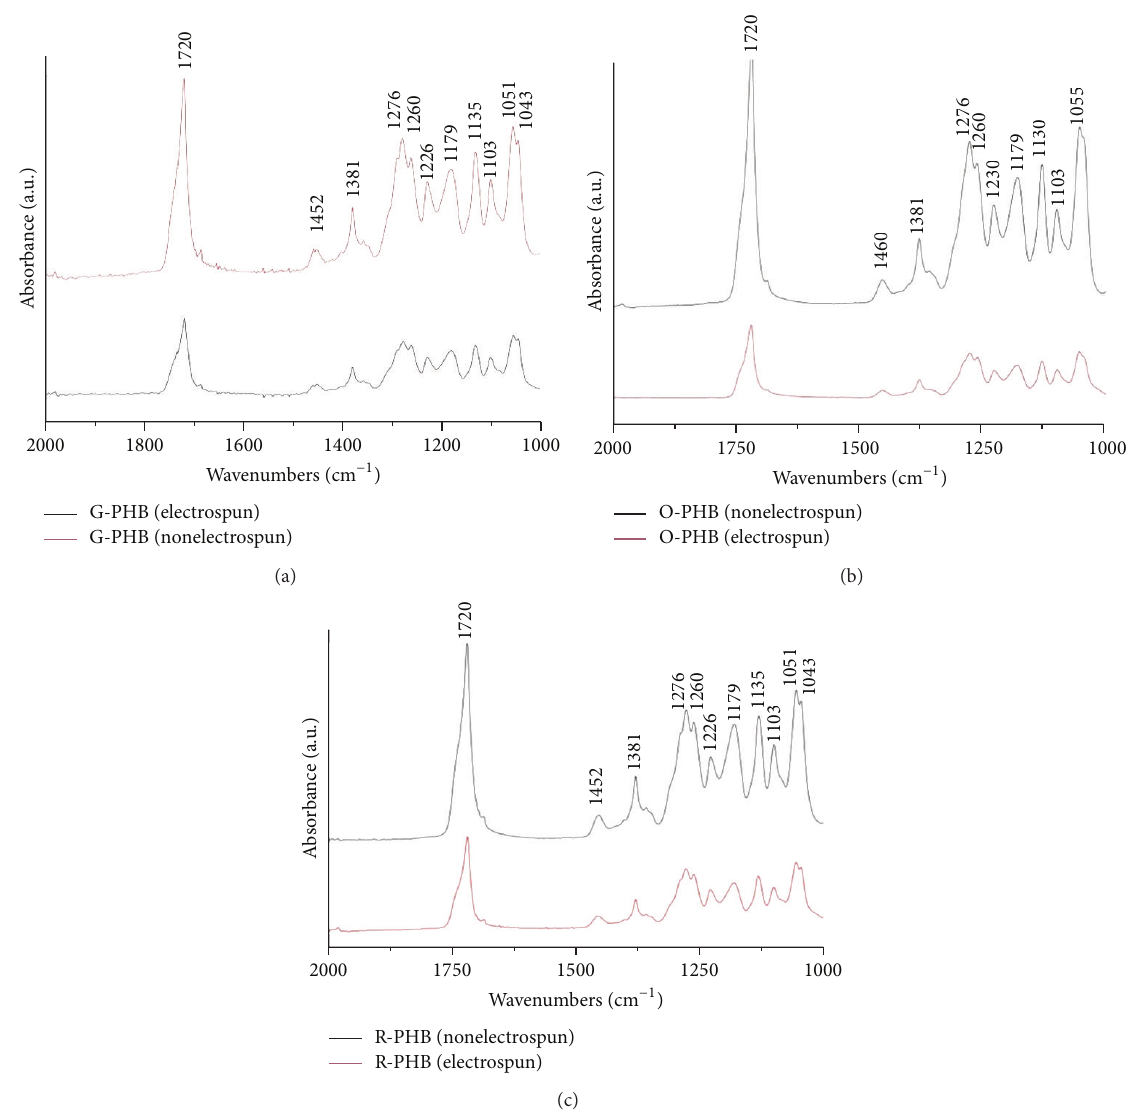
Figure 2: FTIR spectra of electrospun and nonelectrospun samples of PHB obtained from (a) glucose, (b) olive oil, and (c) rapeseed oil.